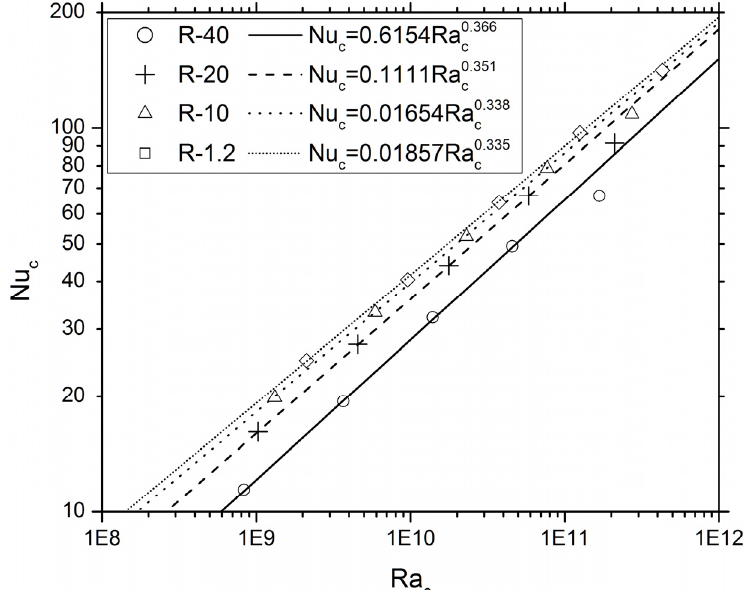
Figure 10. Correlations for attic cooling load compared with numerical